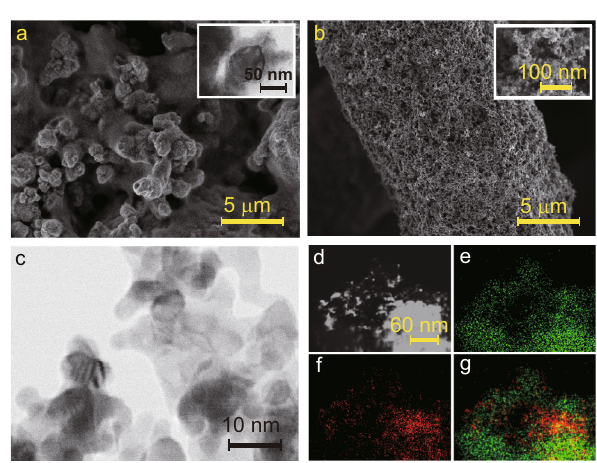
Fig. 2 Electron microscopy characterization of MEA electrolyser catalysts. a Scanning electron microscopy (SEM) and transmission electron microscopy (TEM, inset) images of the cathodic catalyst: Cu nanoparticles/PFSA composite. b SEM images of the anodic catalyst: Pt/C loaded on hydrophilic carbon fi bers. c SEM images of the Pt/C catalyst. d – g The scanning transmission electron microscopy image ( d ) and corresponding Energy-dispersive X-ray spectroscopy (EDS) elemental mappings of carbon ( e ), platinum ( f ), and overlap ( g ) for Pt/C